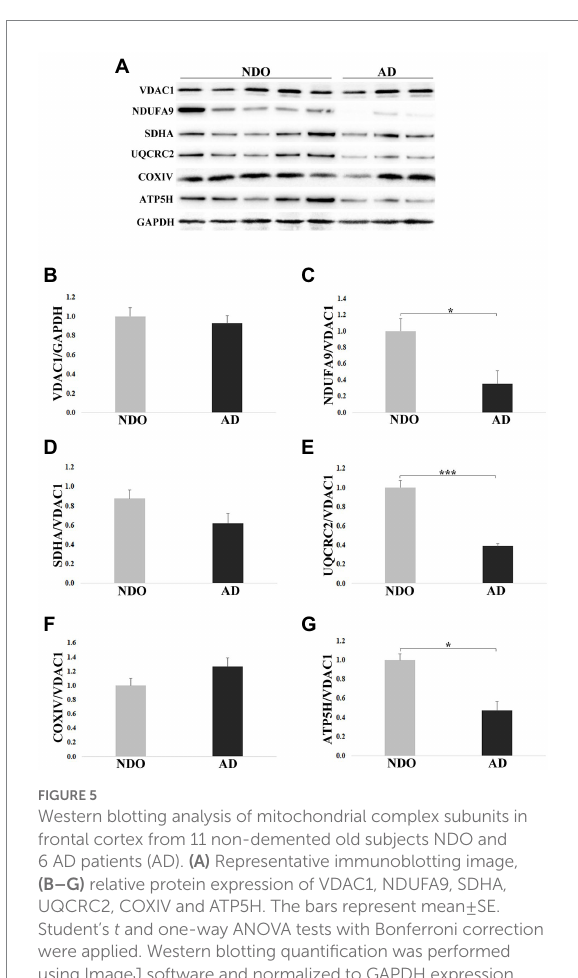
FIGURE 5 Western blotting analysis of mitochondrial complex subunits in frontal cortex from 11 non-demented old subjects NDO and 6 AD patients (AD). (A) Representative immunoblotting image, (B–G) relative protein expression of VDAC1, NDUFA9, SDHA, UQCRC2, COXIV and ATP5H. The bars represent mean ± SE. Student’s t and one-way ANOVA tests with Bonferroni correction were applied. Western blotting quantification was performed using ImageJ software and normalized to GAPDH expression. Relative expression of OXPHOS proteins was normalized to VDAC1 expression. * p < 0.05. *** p <